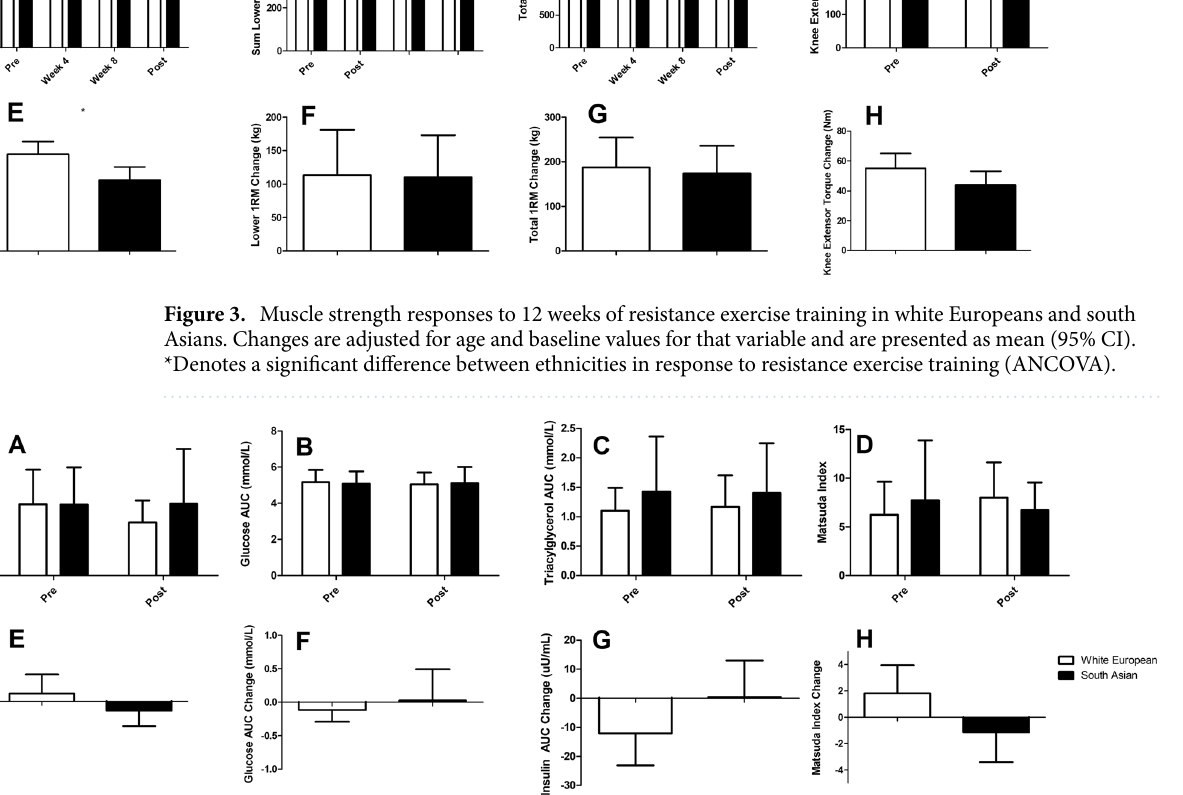
Figure 4. Glucose, triacylglycerol, insulin and Matsuda index responses to 12 weeks of resistance exercise training in white Europeans and south Asians. Changes are adjusted for age and baseline values for that variable and are presented as mean (95%